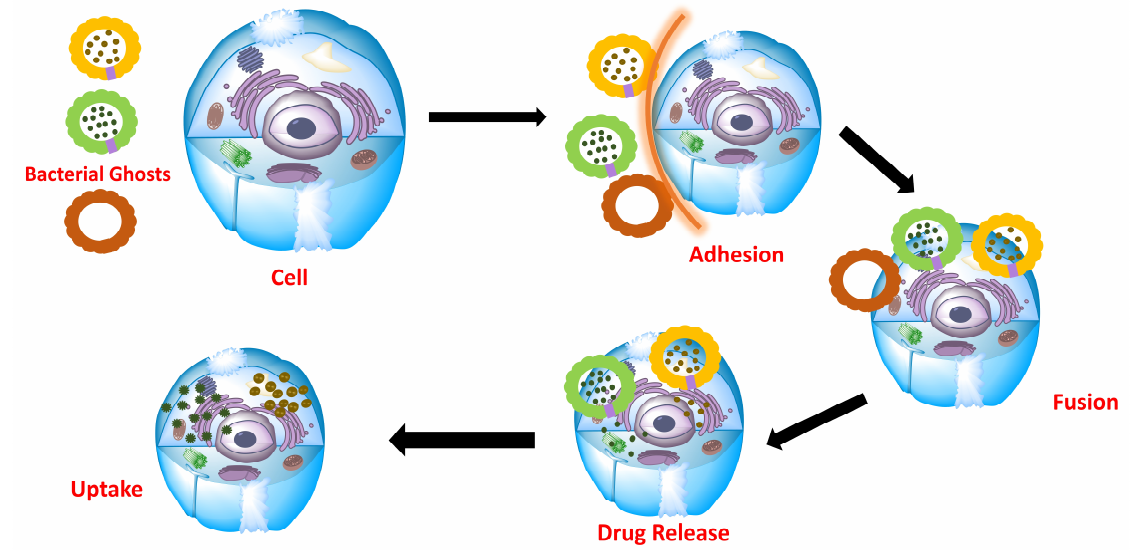
Figure 4. Mechanism used to deliver BGs loaded with drugs to their targets.